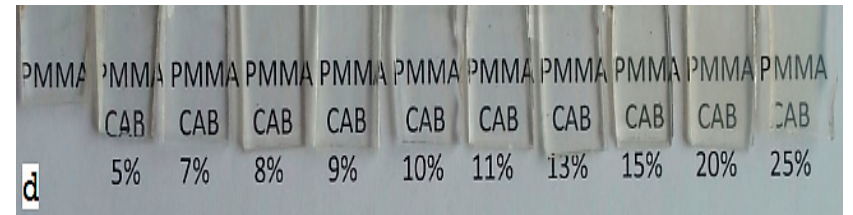
Figure 1. ( a ) Absorbance of PMMA and CAB in different concentrations at 226 nm; ( b ) transmittance of PMMA and CAB in different concentrations at 798 nm; ( c ) PMMA/CAB absorbance and transmittance spectrum with concentration; and ( d ) PMMA/CAB sheets in different concentrations.